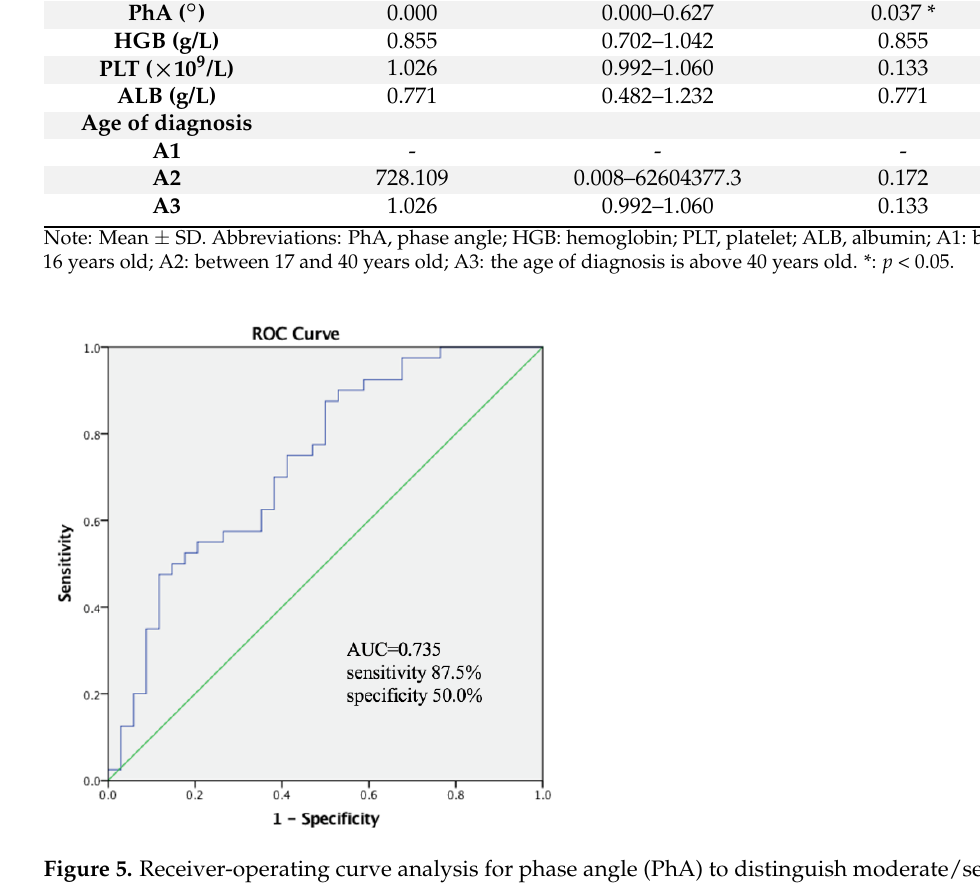
Table 6. Logistic regression analysis of predictors’ degree of malnutrition based on GLIM criteria in women.